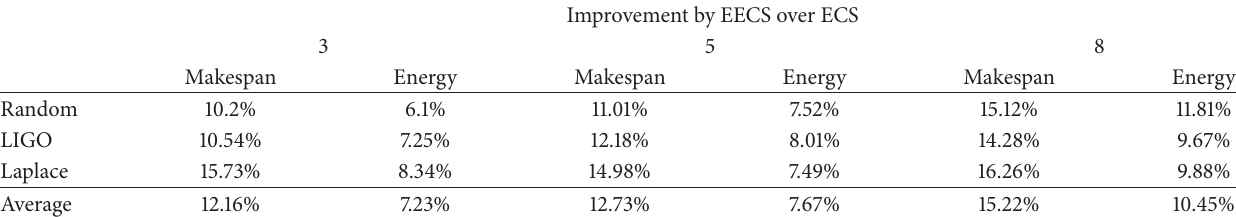
Table 7: Comparative results of different sizes of